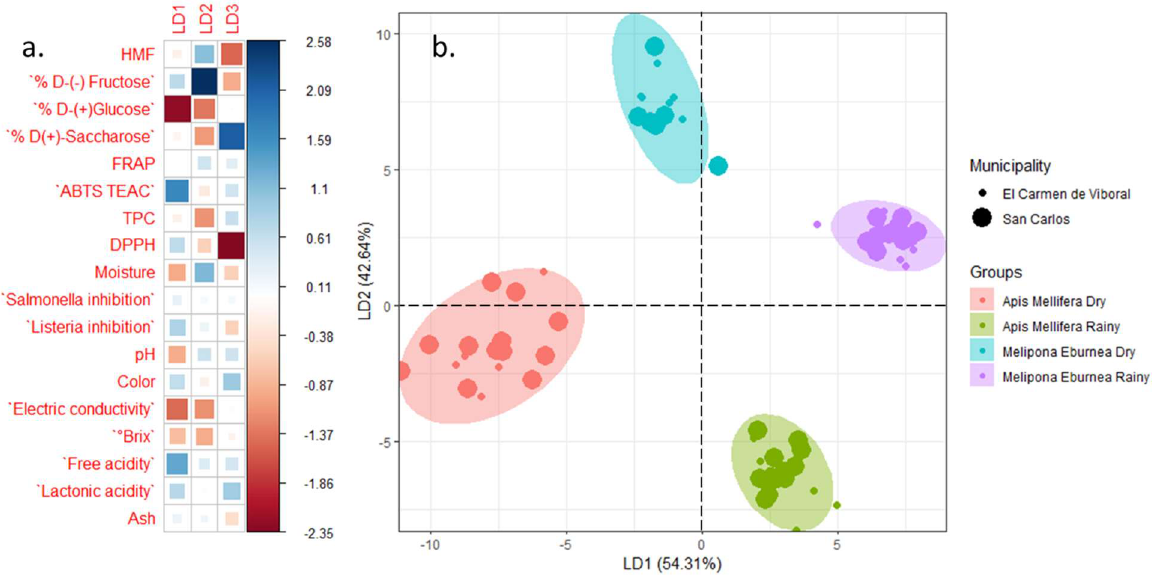
Figure 2. Linear discriminant analysis for honey produced by Apis mellifera and Melipona eburnea in humid and dry harvesting seasons of tropical Colombian forest. ( a ) Discriminant weight of the variables associated with quality. Larger size of the squares and more color intensity indicates higher discriminant weight. ( b ) Cluster plot showing clustering of honey by the interaction of bee species and honey harvesting season.